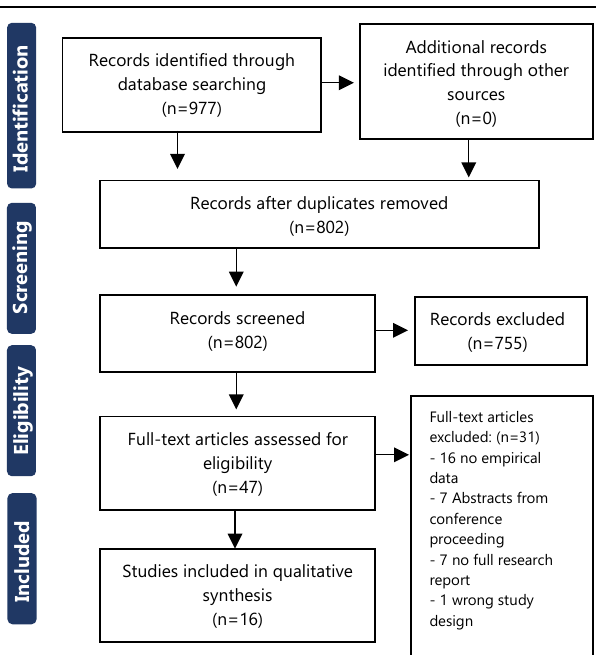
Figure 1 . PRISMA Diagram of Article Selection